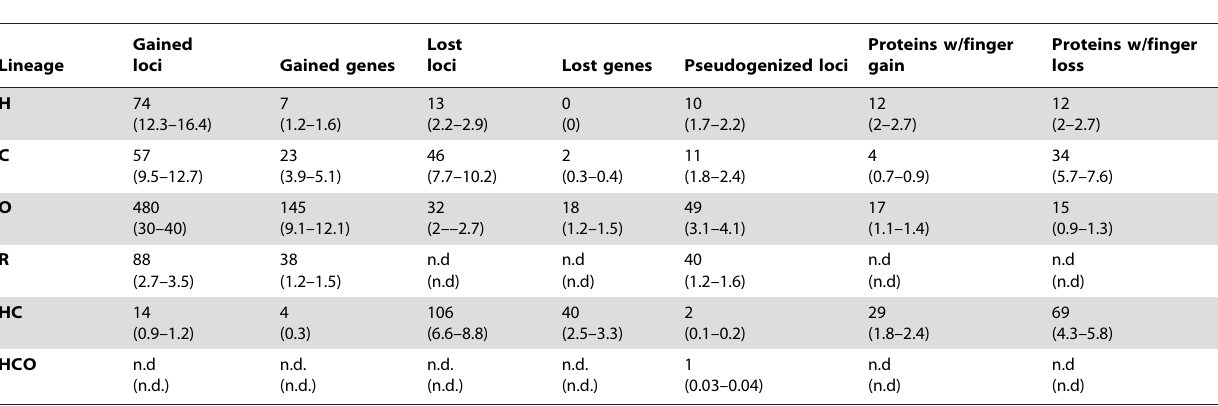
ZNF492 and ZNF286B are human-specific genes. Table 2. Number of loci and genes gained and lost in a lineage-specific way as well as the number of lineage-specific pseudogenes and proteins with lineage-specific gain or loss of ZNF